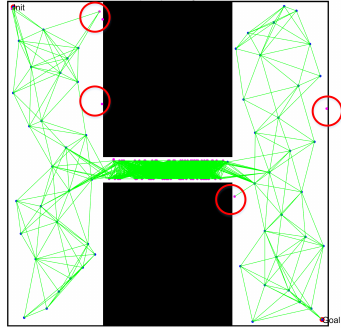
Figure 17. Free space construction based on the optimized PRM algorithm (Points in the red circles are not connected to other